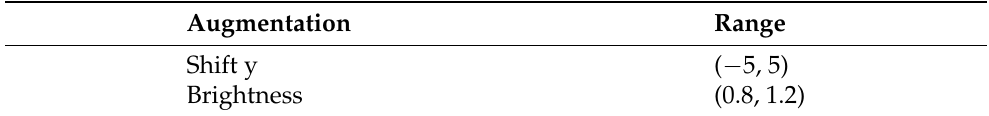
Table 3. Data augmentation